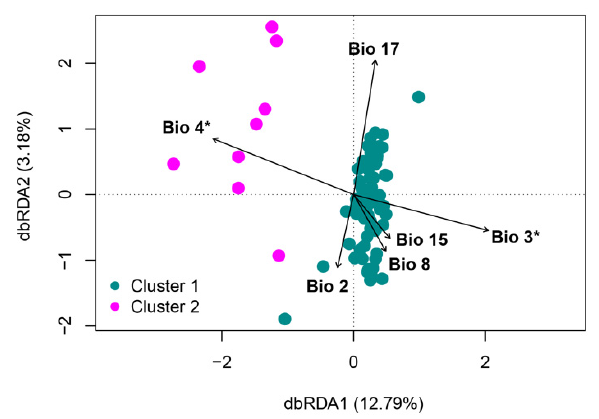
Figure 4. dbRDA ordination plot illustrating the relationship between the bioclimatic variables (Bio) as explanatory predictors for the genetic distances. Individuals are colored according to their genetic cluster inferred with the DAPC. Asterisk annotation indicates statistical significance. Bioclimatic variables: Bio 2, annual mean diurnal range; Bio 3, isothermality × 100; Bio 4, temperature seasonality (SD × 100); Bio 8, mean temperature of the wettest quarter; Bio 15, precipitation seasonality CV; Bio 17, precipitation of the driest quarter.